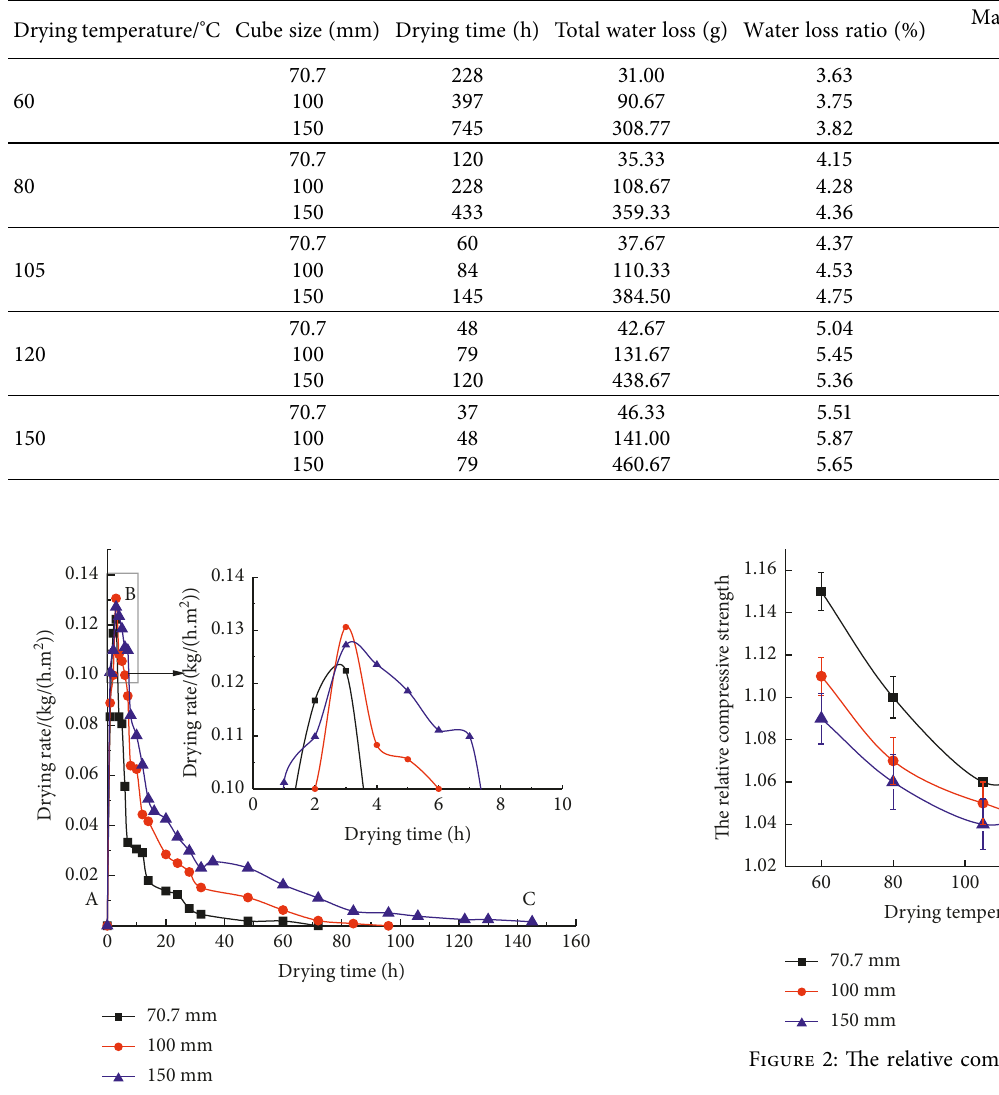
Figure 1: Drying curves of C30 concrete of different sizes at 105 ° C.